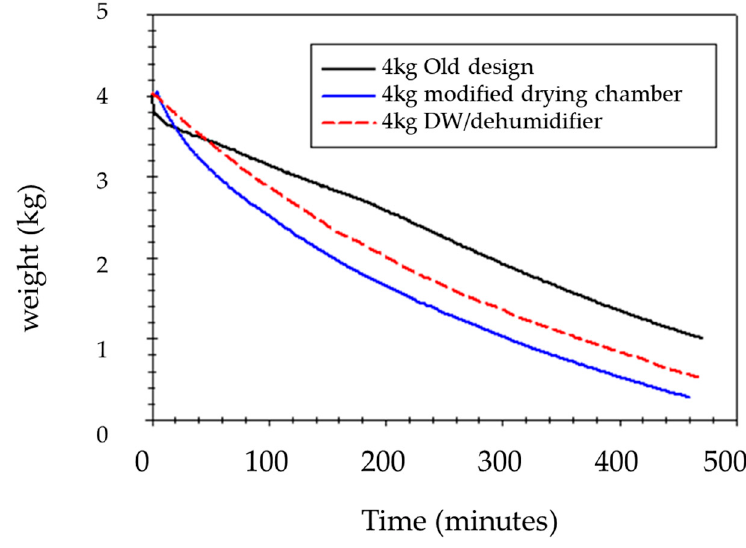
Figure 11. Weight reduction for the minimum test load.